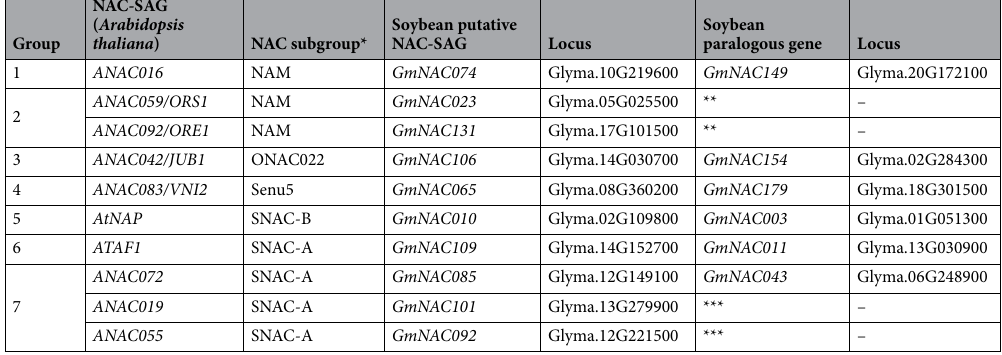
Table 1. Senescence-associated genes in Arabidopsis thaliana and soybean ( Glycine max ). *According to Melo et al. (2018). ** GmNAC023 and GmNAC131 are putative soybean paralogous genes. *** GmNAC092 and GmNAC101 are putative soybean paralogous genes.